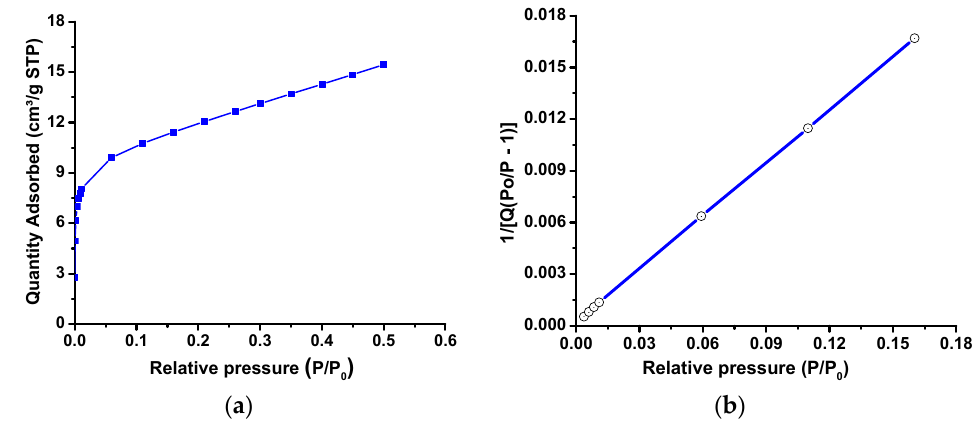
Figure 4 . ( a ) BET isotherm linear plot ( b ) BET surface area plot for Cu-ZnO/TiO 2 (CZT-2) nanocom- posite photocatalyst.